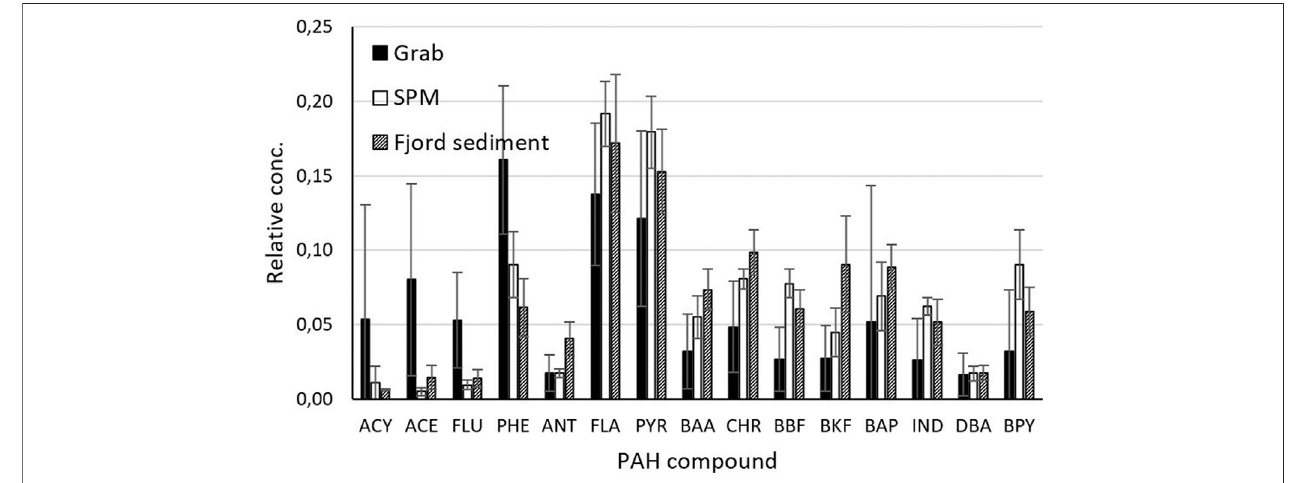
FIGURE 5 | PAH pro fi les, expressed as the fraction of each compound as part of the total PAH 15 concentration, in the grab water samples (n (cid:1) 23), SPM samples (n (cid:1) 6) compared to sediments in the Oslo fjord near the river mouth (n (cid:1) 5) from Arp and Breedveld (2009).